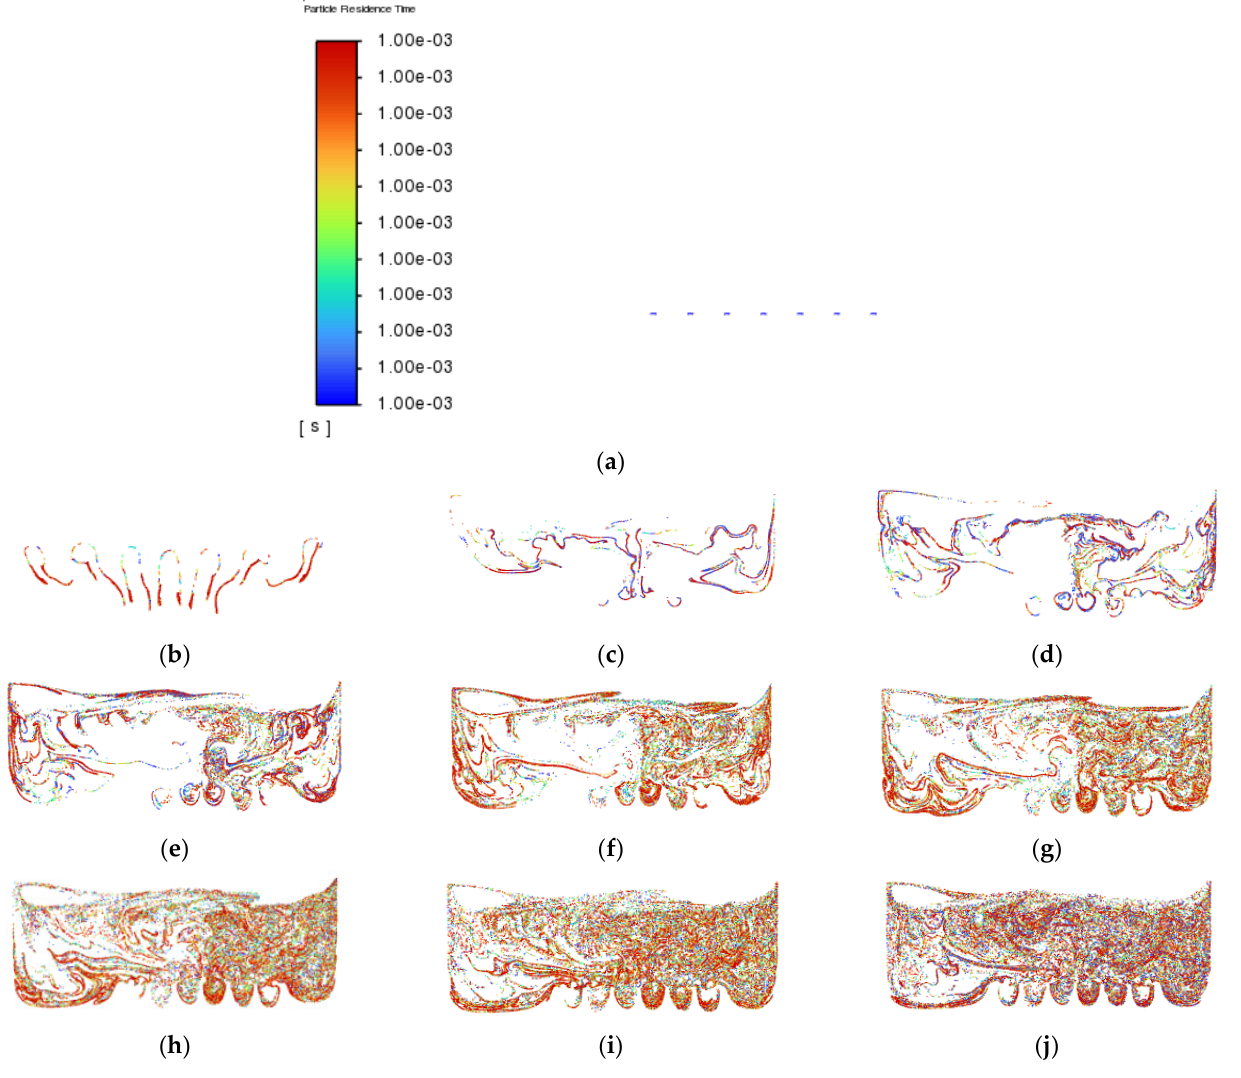
Figure 11. Particle tracking of Simulation 3: ( a ) 0.0 s; ( b ) 0.5 s; ( c ) 1.0 s; ( d ) 1.5 s; ( e ) 2.0 s; ( f ) 2.5 s; ( g ) 3.0 s; ( h ) 3.5 s; ( i ) 4.0 s; ( j ) 4.5 s.